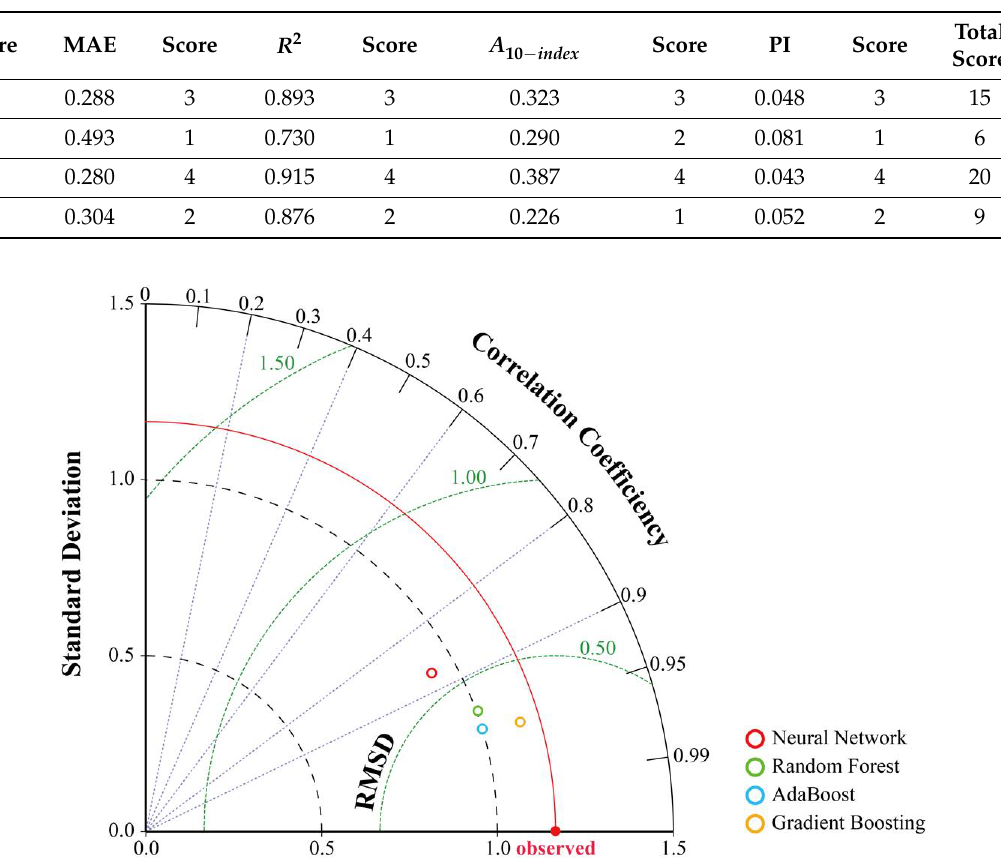
Table 12. Comprehensive evaluation of ML models.